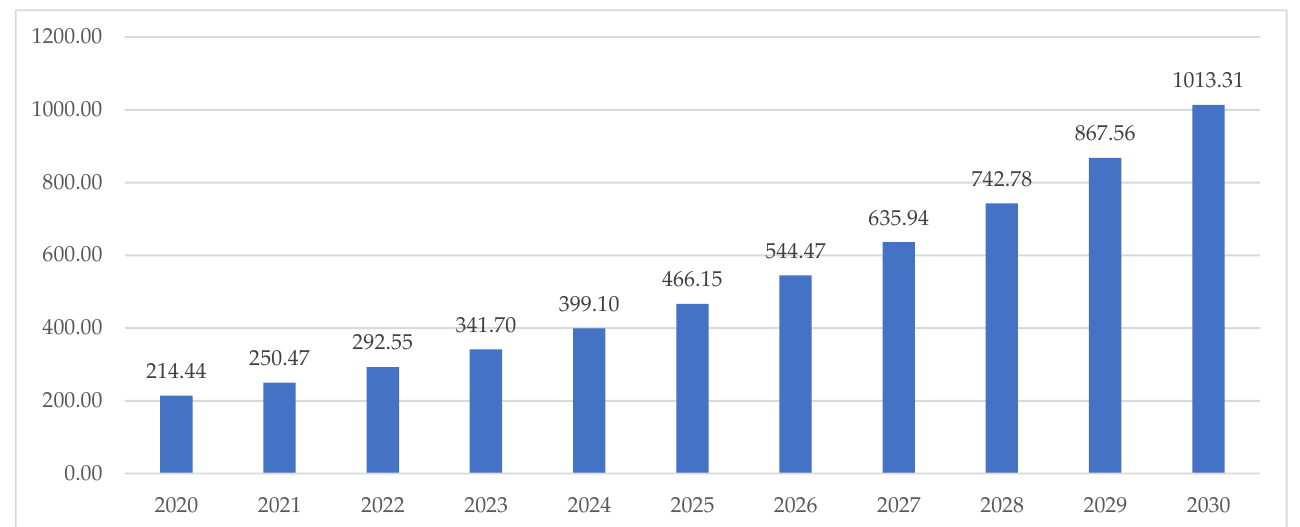
Figure 3. The value of global revenues from smart city technologies, products, and services in 2020-2030, on the basis of Statista data, along with the authors’ own forecast. Source: ([83], own elaboration).